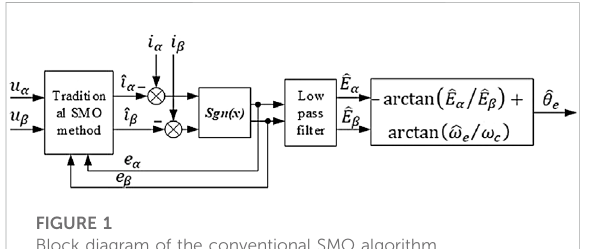
FIGURE 1 Block diagram of the conventional SMO algorithm.